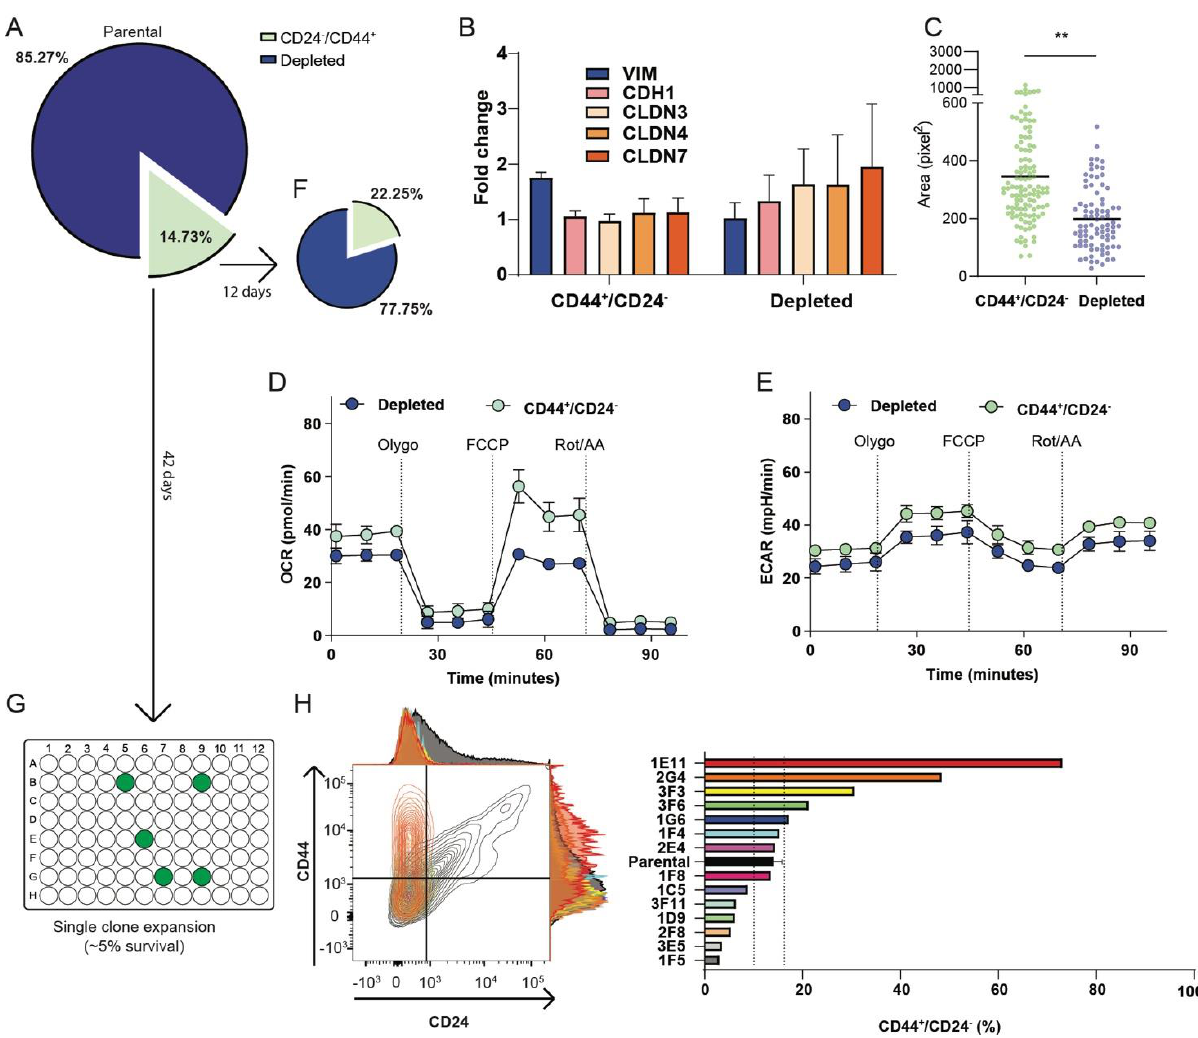
Figure 5. Characterization of CD44 + /CD24 - subpopulation. The OVCAR3 subpopulation defined by CD44 + /CD24 - phenotype was separated by cell sorting ( A ) and plated in culture for 12 days. Immunostaining with anti-CD44 and anti-CD24 followed by FACS analysis was then repeated ( F ). ( B ) Total RNA was extracted from the sorted CD44 + /CD24 - cells and depleted OVCAR3, and the expression level of epithelial and mesenchymal markers was measured by RT-qPCR; bars represent mean ± SD of two independent experiments. ( C ) CD44 + /CD24 - and unsorted OVCAR3 cells were embedded in soft agar to measure the anchorage-independent cell growth.**, p < 0.01 independent sample t test. ( D – E ) Energy metabolism. Seahorse XF Cell Mito Stress Test (OCR: oxygen consumption rate; ECAR: extracellular acidification rate) performed by Seahorse platform in CD44 + /CD24 - and unsorted OVCAR3 cells. ( G – H ) The sorted CD44 + /CD24 - cells as described in ( A ) were individually plated and emerging single clones analyzed by FACS for CD44 and CD24 expression.